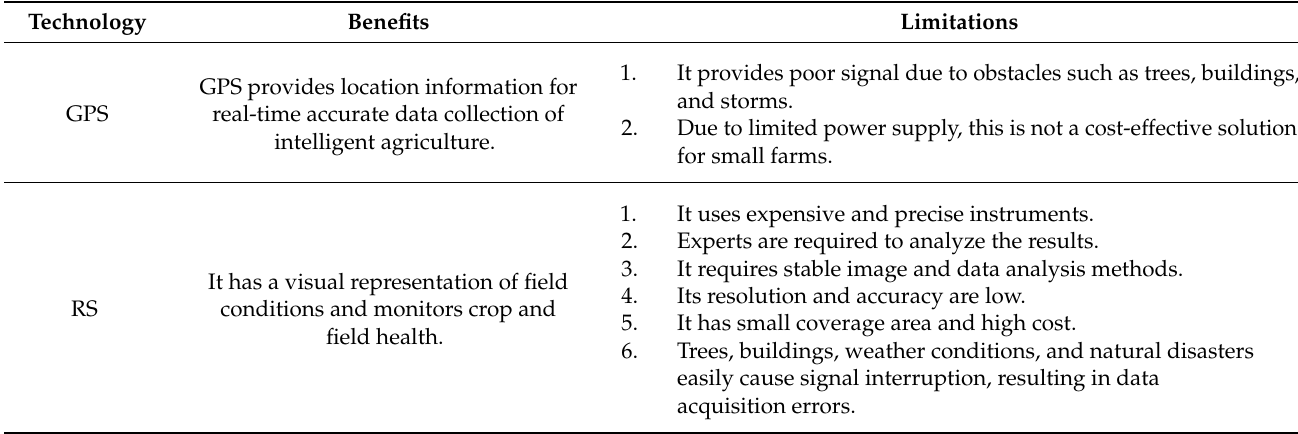
Table 1. Comparison of advantages and